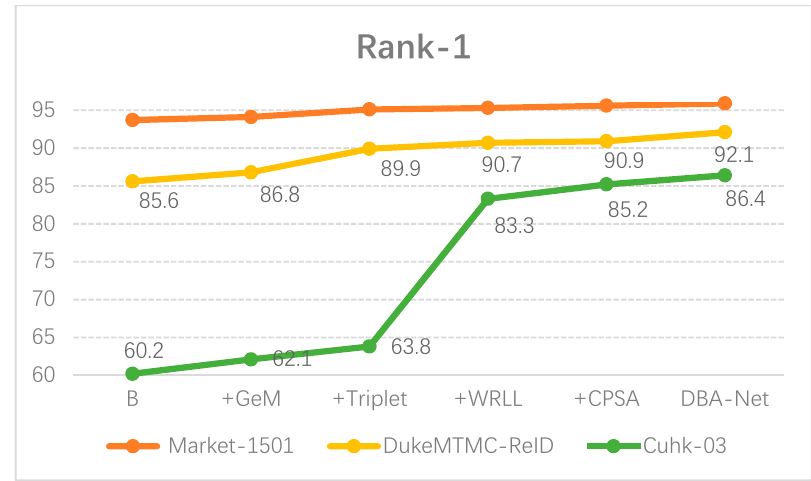
Figure 8. The mAP value of DBA ‐ Net on three datasets.